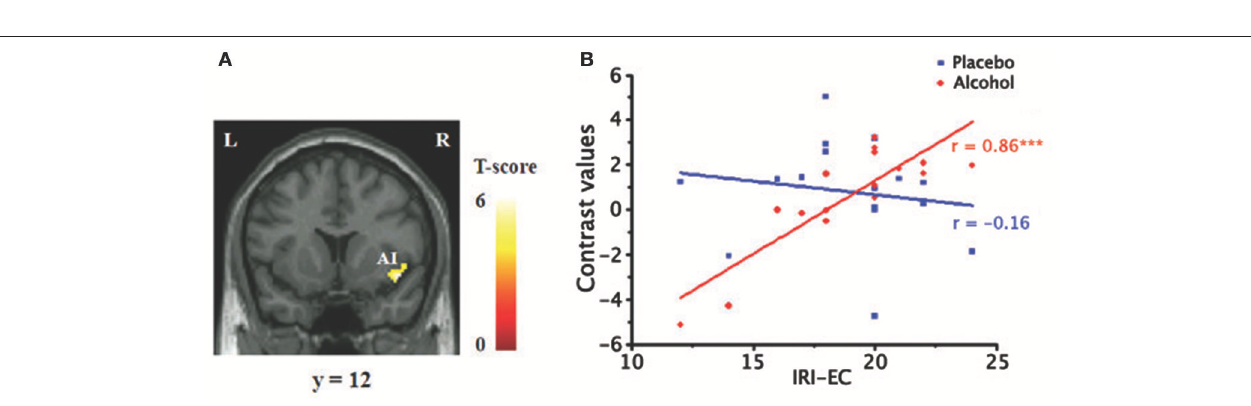
FIGURE 4 | Contrast values of the parameter estimates of the three ROIs of the affective pain matrix in the placebo and alcohol condition: (A) results for the dorsal anterior cingulate cortex (dACC); (B) results for the left anterior insula extending to the inferior frontal gyrus (lAI/IFG); (C) results for the right anterior insula extending to the inferior frontal gyrus (rAI/IFG). L, left; R, right; * p < 0.05, ** p < 0.01, *** p < 0.001; The error bars represent the SEM.